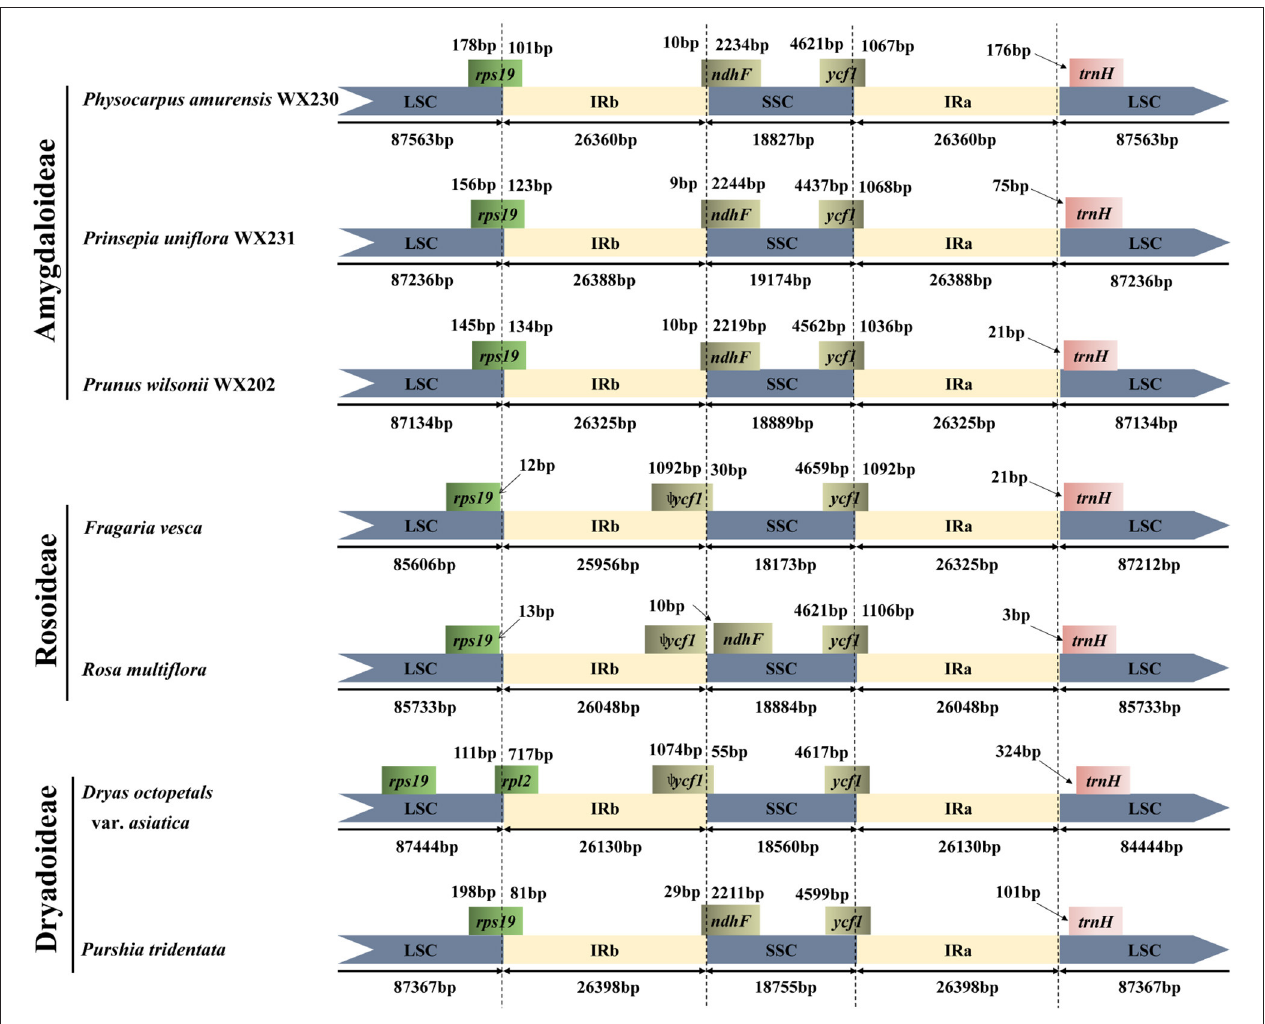
FIGURE 4 | Comparison of the LSC, IRs, and SSC border regions of Maddenia group and other Rosaceae plastomes.